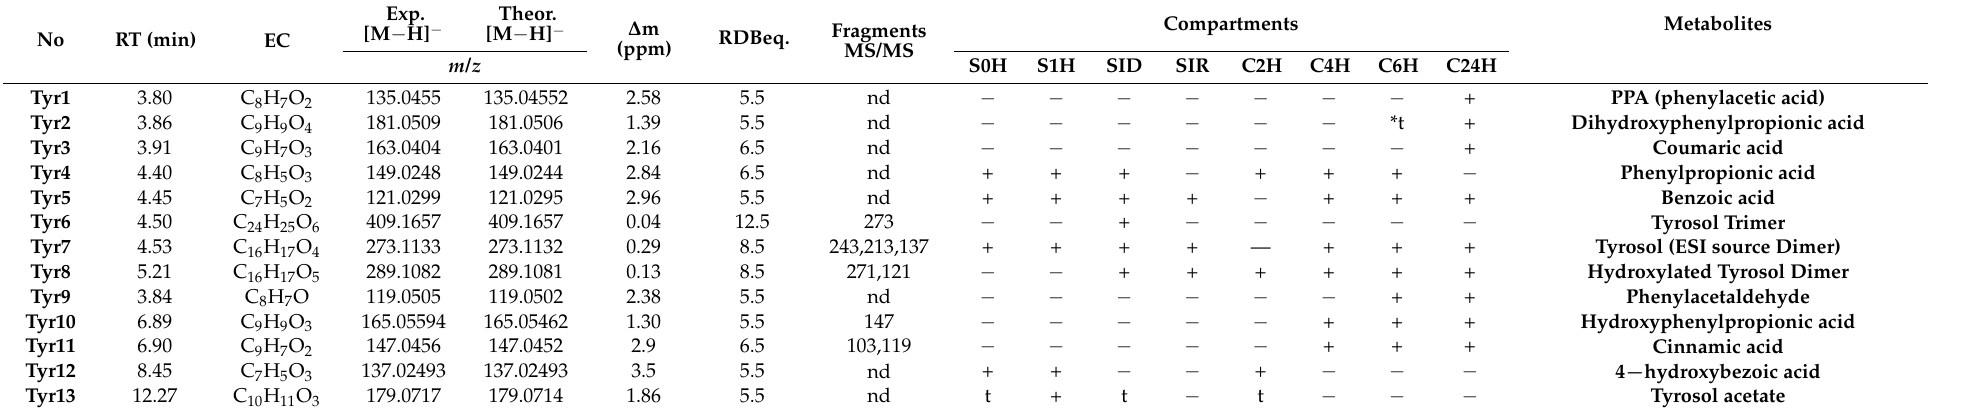
Table 2. Chromatographic and spectrometric information of Tyr